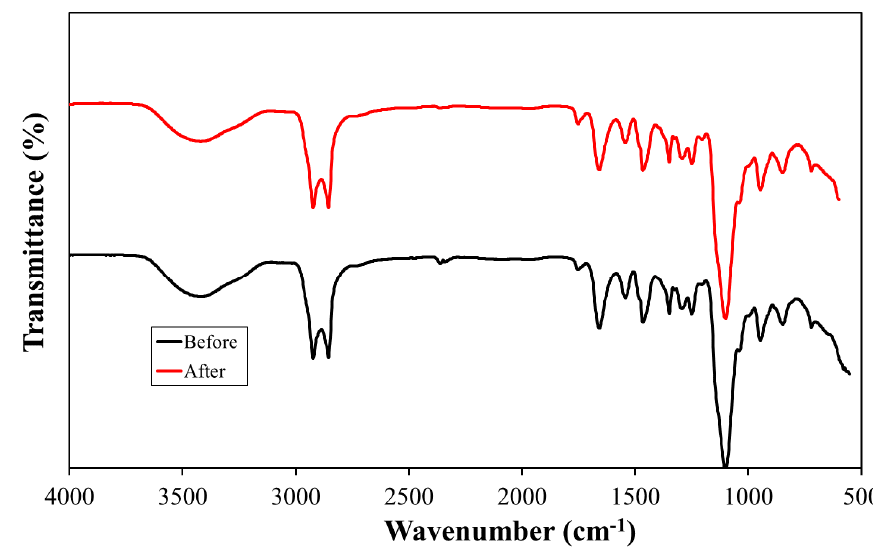
Figure 9. FT-IR spectra of GS10 before aging and after aging.